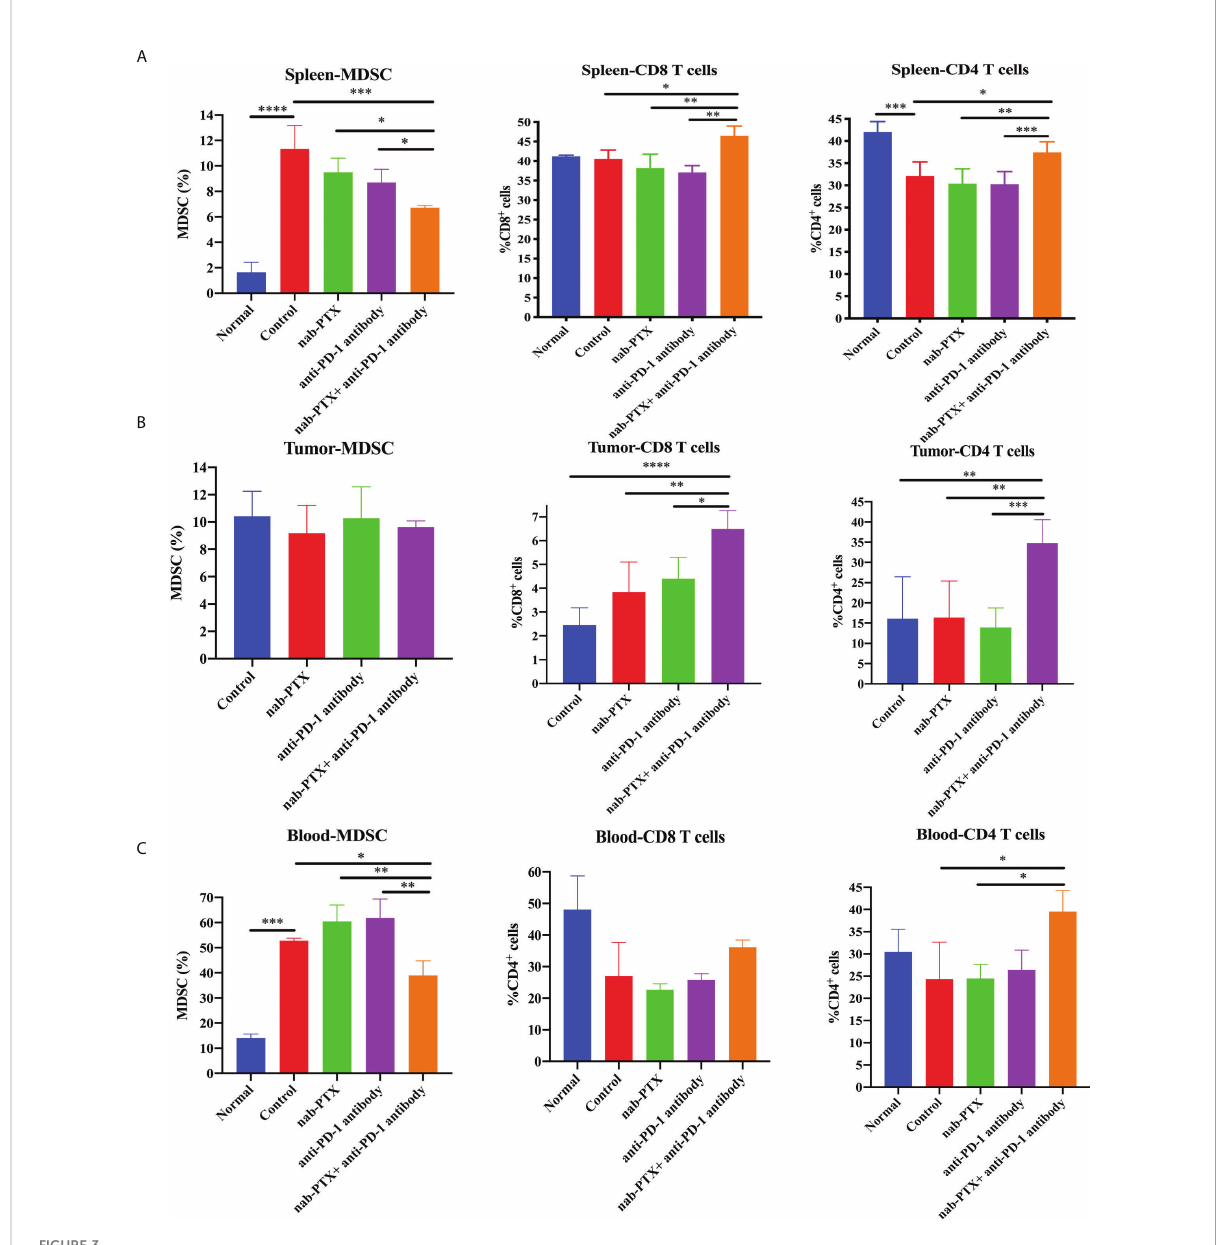
FIGURE 3 The combination of nab-PTX and anti-PD-1 antibody regulates immune in fi ltration. The frequency of MDSCs, CD8 + T cells, and CD4 + T cells in the (A) spleen ( n = 3, biological duplicates), (B) tumor ( n = 5, biological duplicates), and (C) blood ( n = 3, biological duplicates) using one-way ANOVA followed by Tukey ’ s multiple comparisons. * p < 0.05, ** p < 0.01, *** p < 0.001, **** p <